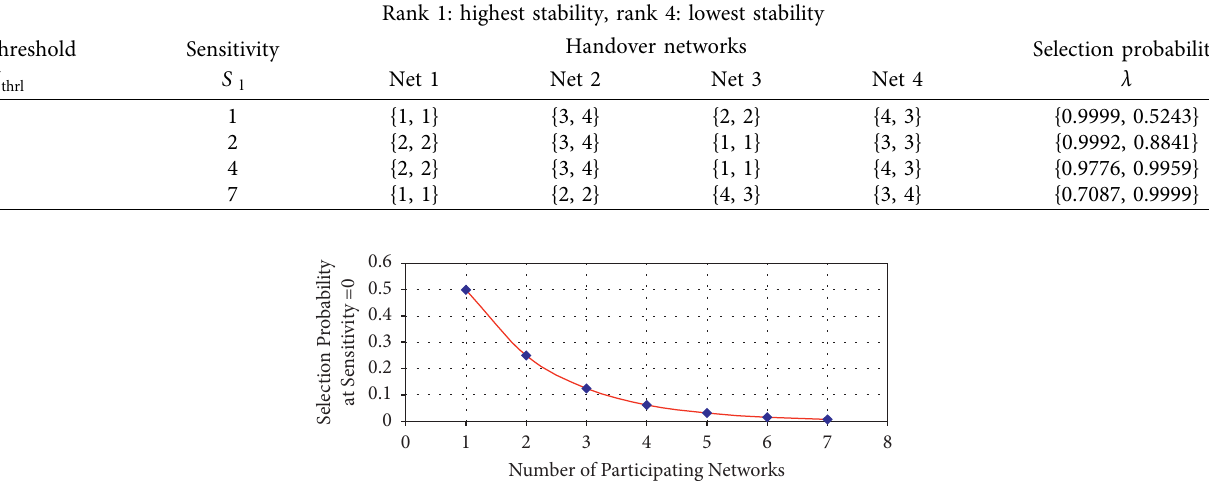
Figure 25: Relationship between selection probability and number of